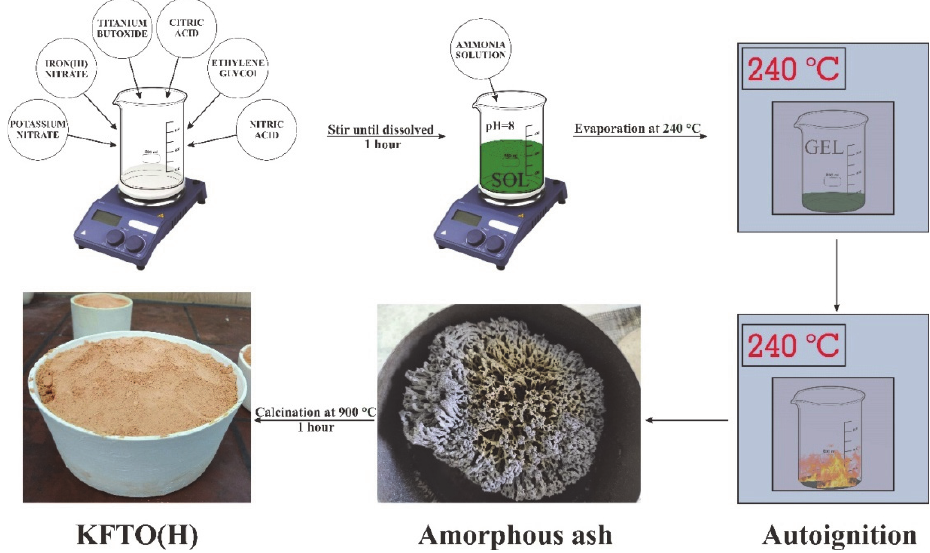
Figure 1. KFTO(H) synthesis